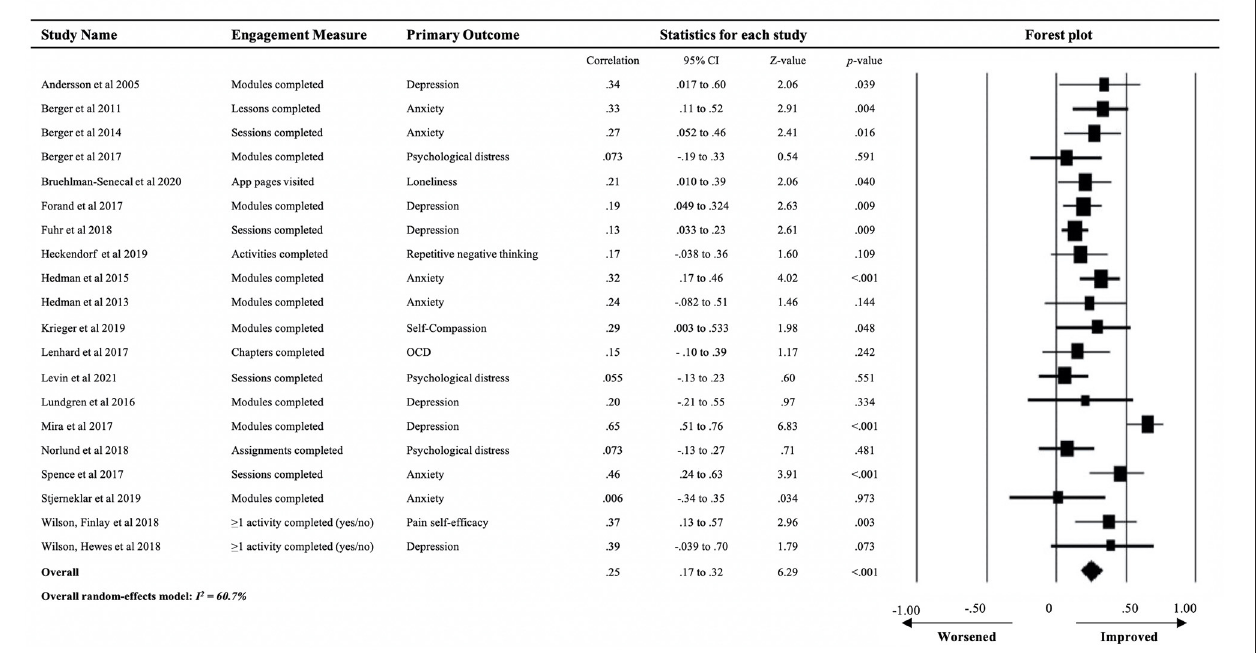
FIGURE 2 | Association between engagement and primary mental health outcomes at post-intervention for studies employing correlational designs ( n = 20).